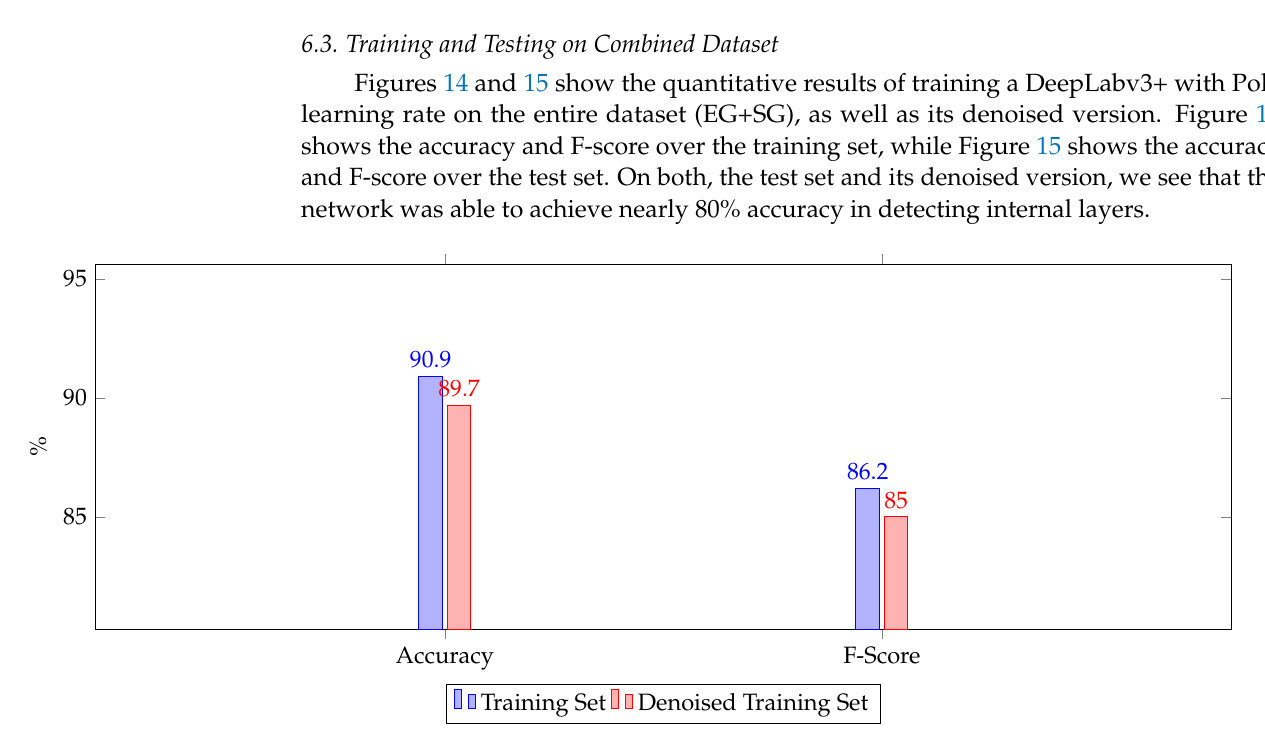
Figure 14. Accuracy and F-1 score obtained over the combined training set and the combined denoised training set.